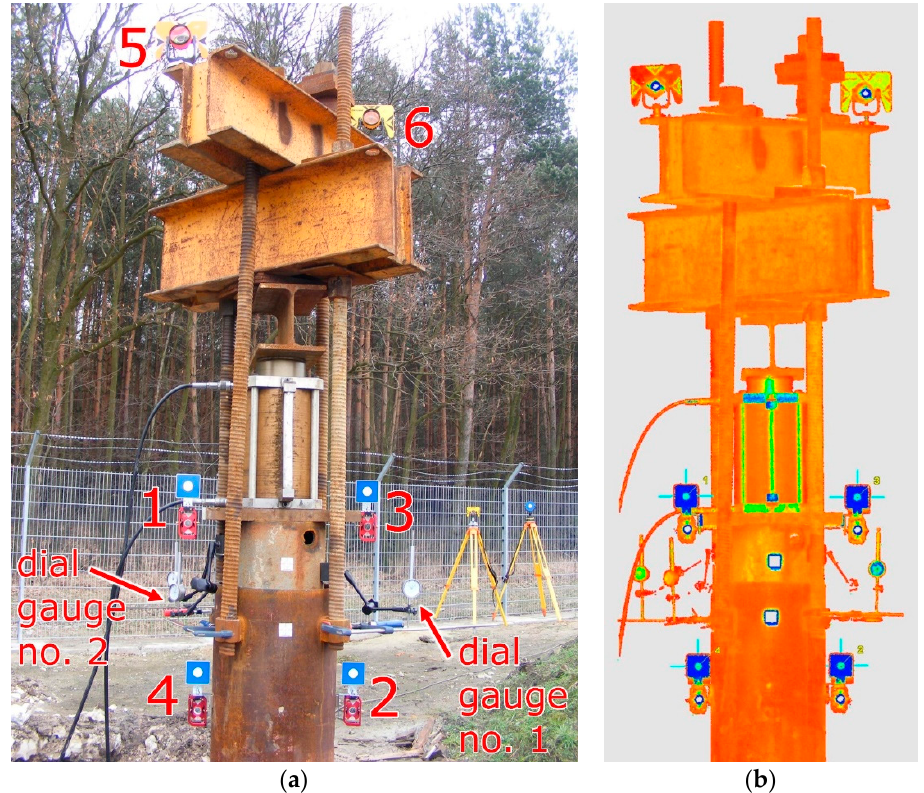
Figure 8. The self-balanced testing appliance: ( a ) checkpoints and dial gauges with their numbering; ( b ) point cloud colored by the intensity of reflection.